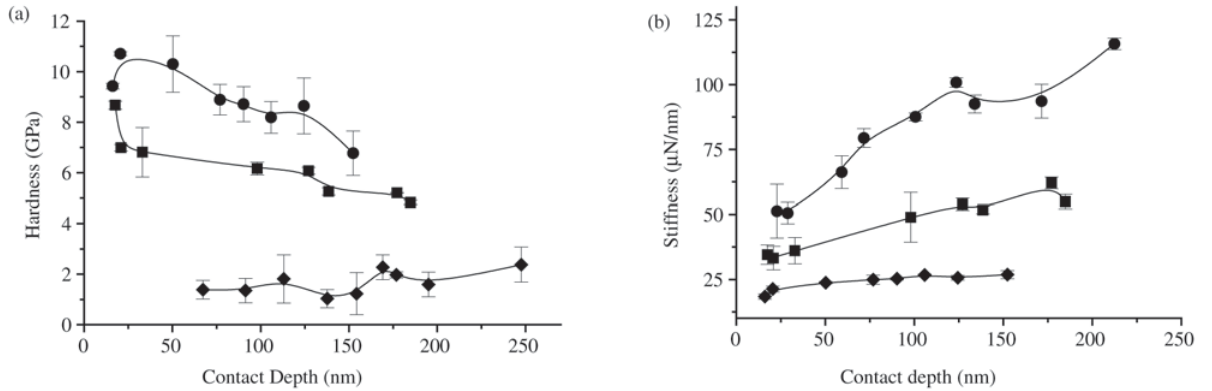
Figure 6. Nano Indentation showing a) surface hardness; b) stiffness of ( (cid:139) ) 10 min diamond growth on molybdenum, ( (cid:122) ) nitrated molybdenum and ( (cid:132) ) 10 min diamond growth on nitrite molybdenum as function of penetration depth.